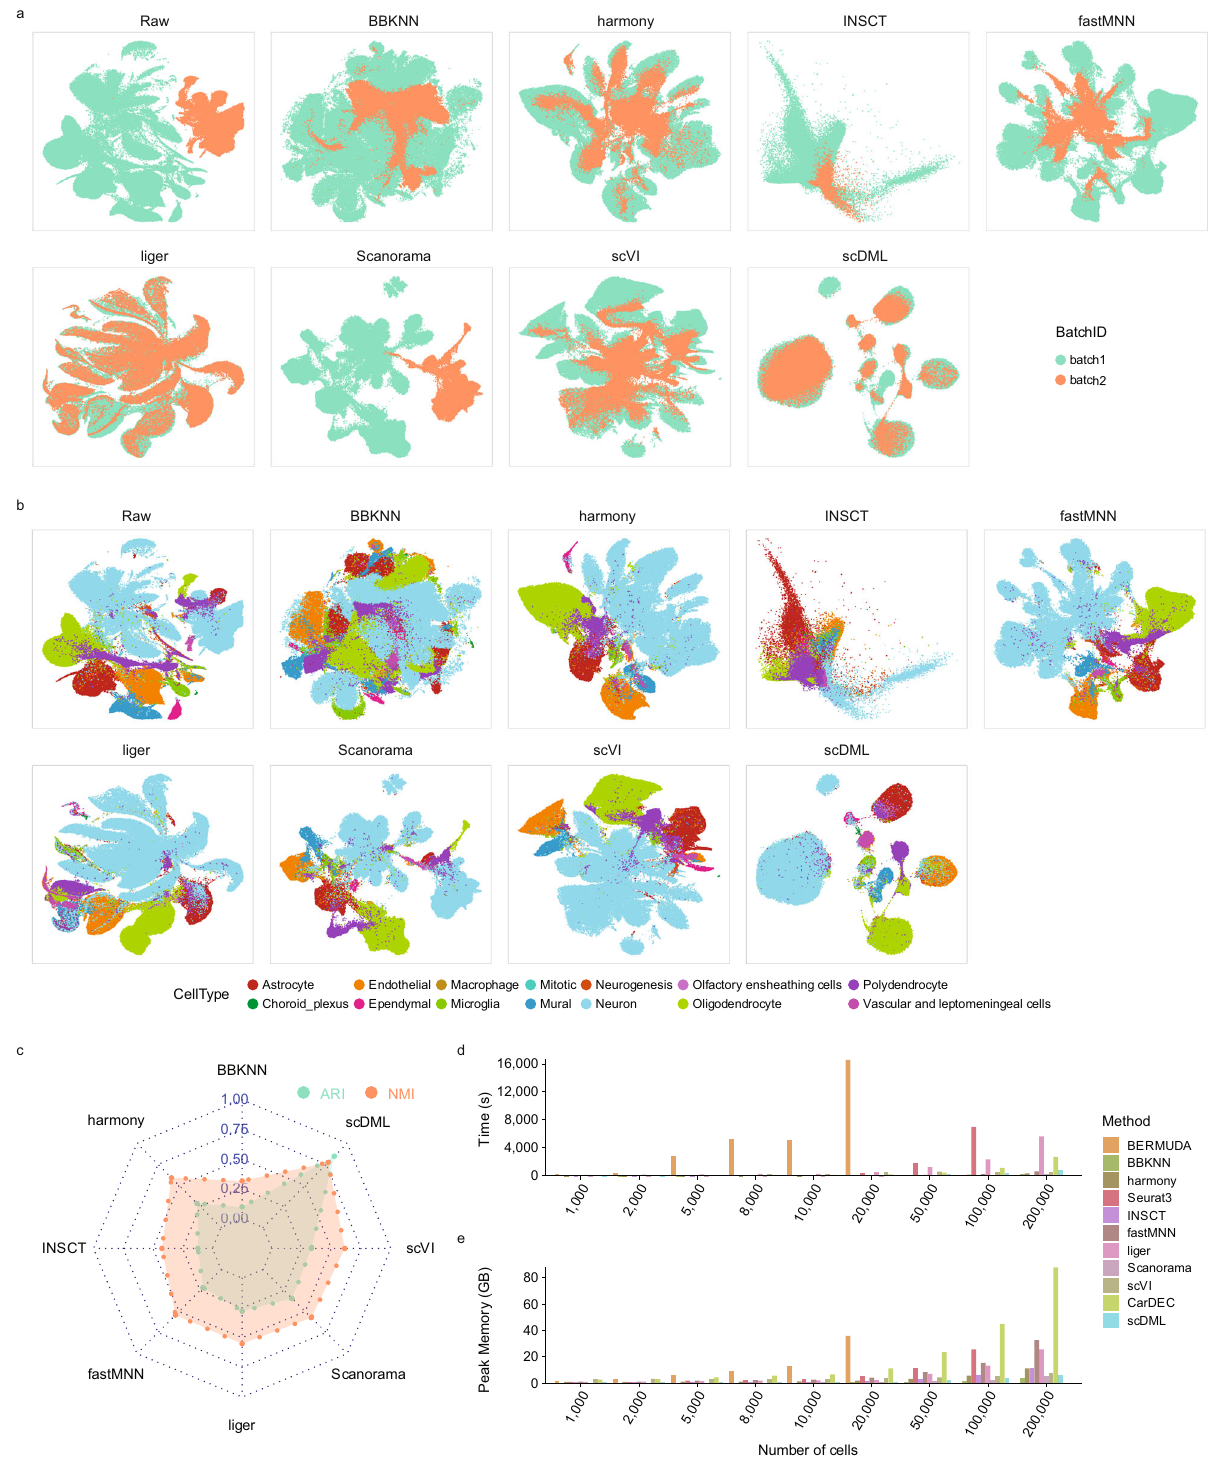
Fig.5|scDMLenablesintegratinglargedatasetsandsimultaneouslyremoving batch effect for the mouse brain dataset. UMAP embedding computed from differentmethods,inwhichthepointsarecoloredbybatch( a )andbycelltype( b ). c Radarplotshowsthevalue ofARIand NMIfordifferentmethods.HigherARIand NMI means better performance. d Bar plot shows the running time of different methods when handling varying number of cells. Lower bar means better perfor- mance. e Bar plot shows the peak memory usage of different methods when handling varying number of cells. Lower bar means better performance. Remark: